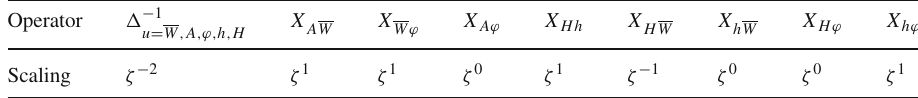
Table 1 Scaling behaviour